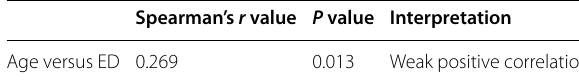
Table 2 Correlation between age and ED